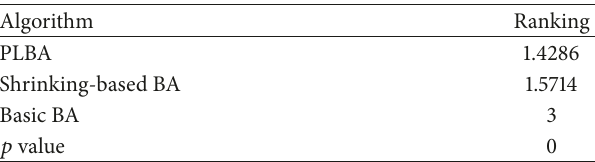
Table 11: Average rankings of BA variants (Friedman) on dynamic benchmark problems 𝐹 1 – 𝐹 6 in terms of both solution quality and convergence speed.